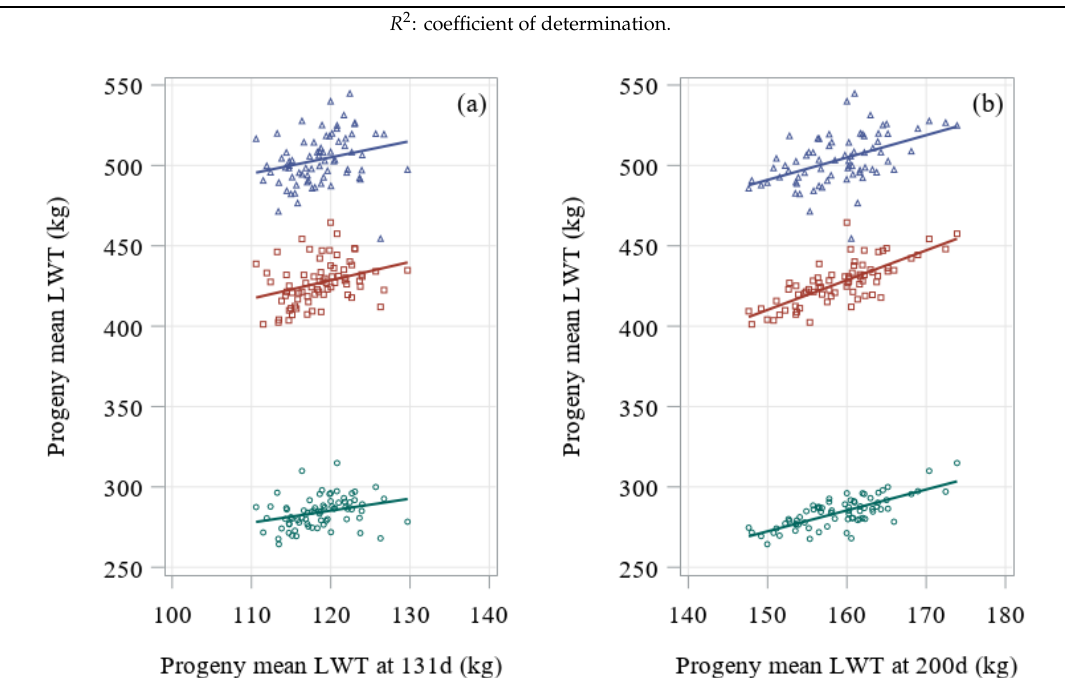
Figure 3. Regression of least-squares means of the progeny groups for live weight (LWT, in kilograms) at 400, 600 and 800 days of age, on least-squares means of the progeny groups for live weight at either ( a ) 131 or ( b ) 200 days of age. Individual sires are represented by one data point, at 400 ( ○ green circles), 600 ( □ red squares) and 800 ( ∆ blue triangles) days of age. The respective regressions are indicated by solid lines.